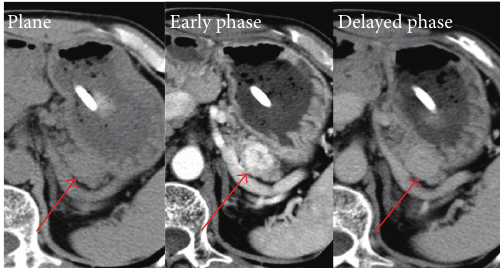
Figure 1: Abdominal computed tomography revealed a hypervas- cular tumor (arrow) in the middle portion of the pancreas in April 2012.